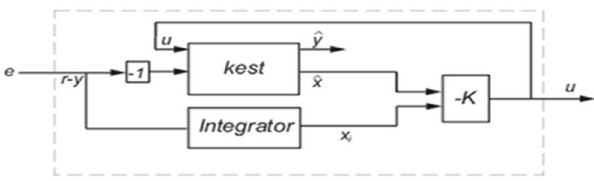
Figure 10. Linear-quadratic-Gaussian (LQG) controller block diagram.